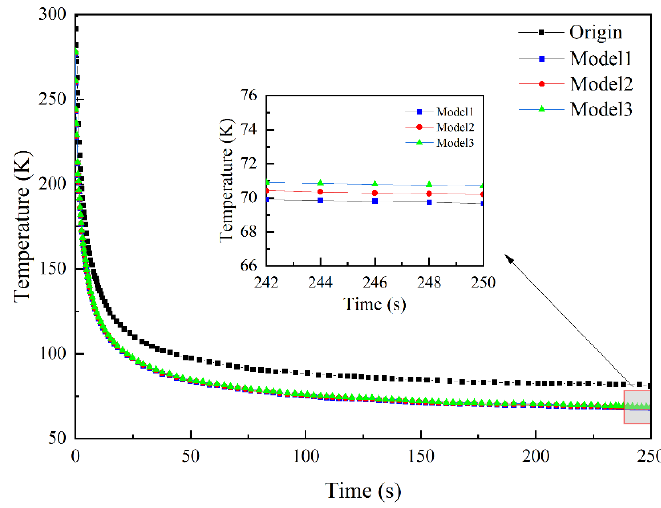
Figure 3. Average minimum cooling temperatures of four models.